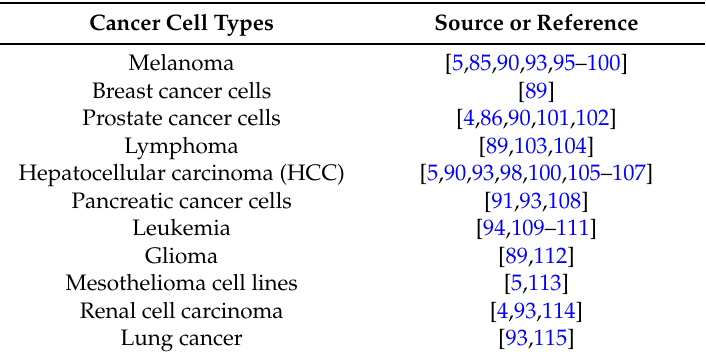
Table 2. Common cancer cells with reduced or absent ASS